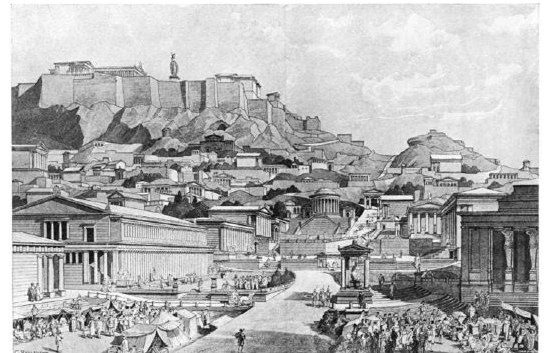
Figure 1. Agora in Athens.Reconstruction by G. Rehlender. From: SpamersillustrierteWeltgeschichte (Spamer’s illustrated history of the world) vol. 1, by O. Kaemmel and R. Sturmhoefel, Leipzig, 1893.